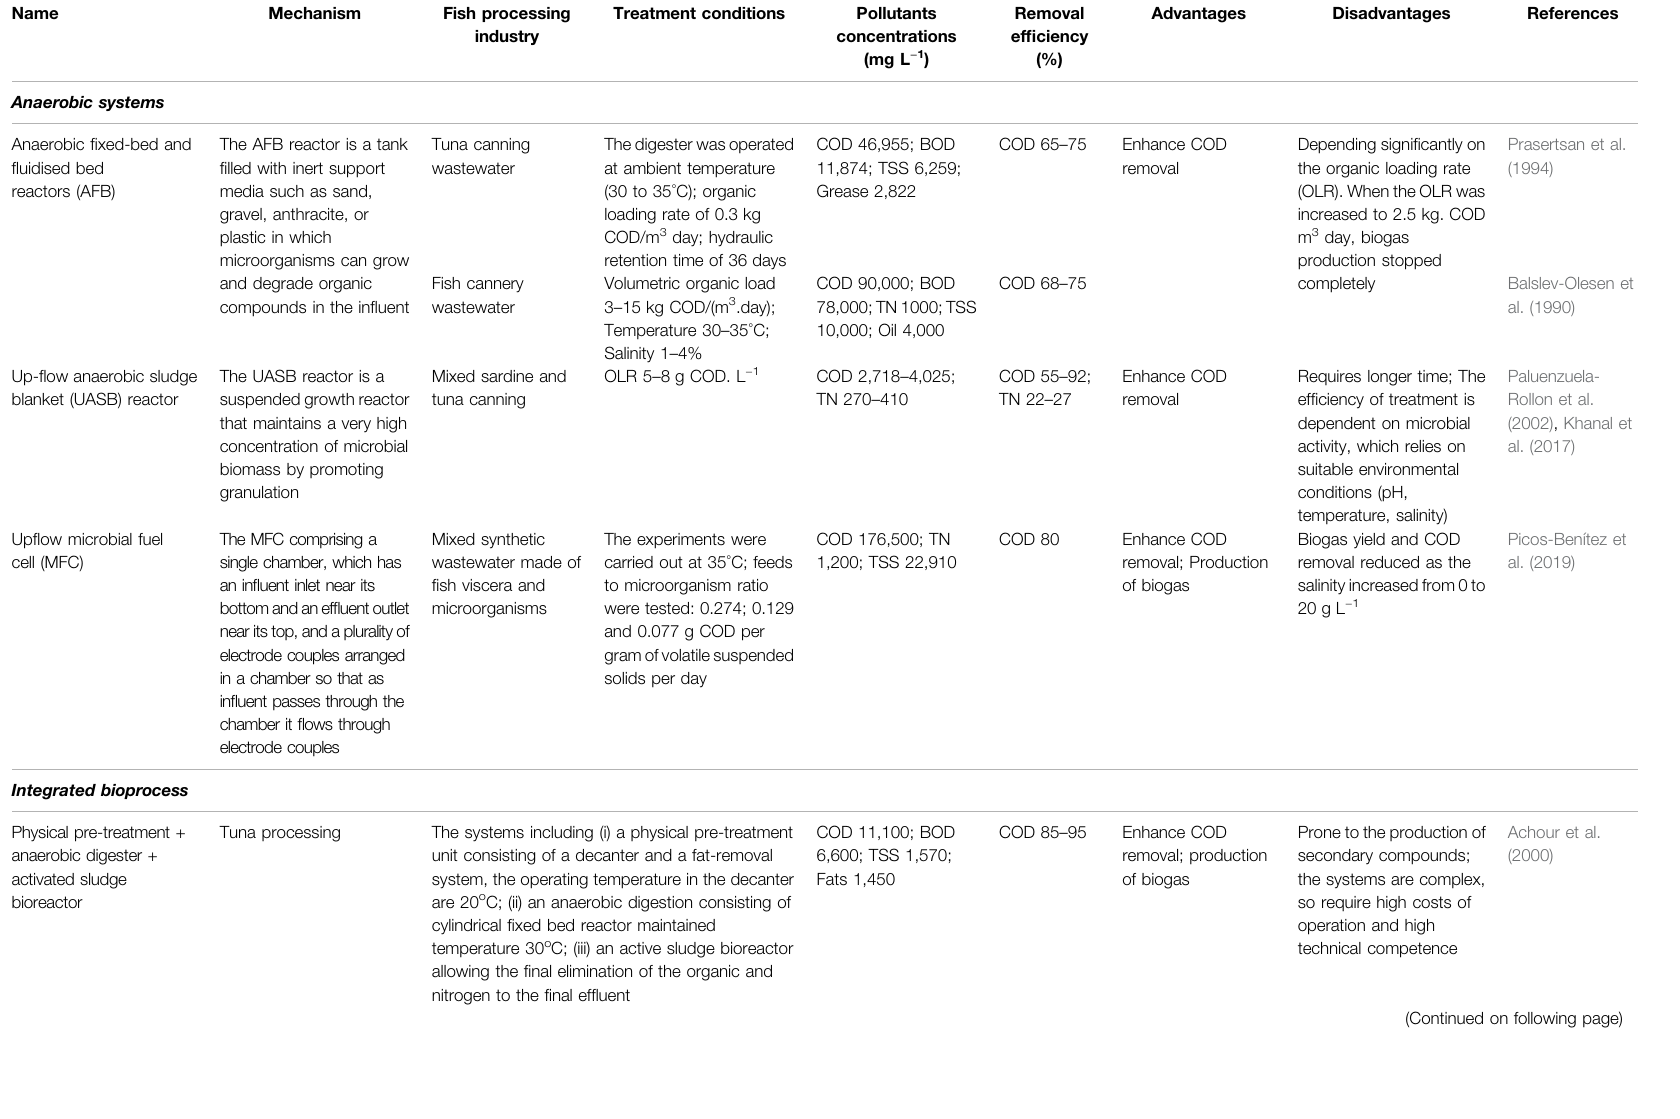
TABLE 2 | ( Continued ) The advantages and disadvantages of current fi sh wastewater treatment